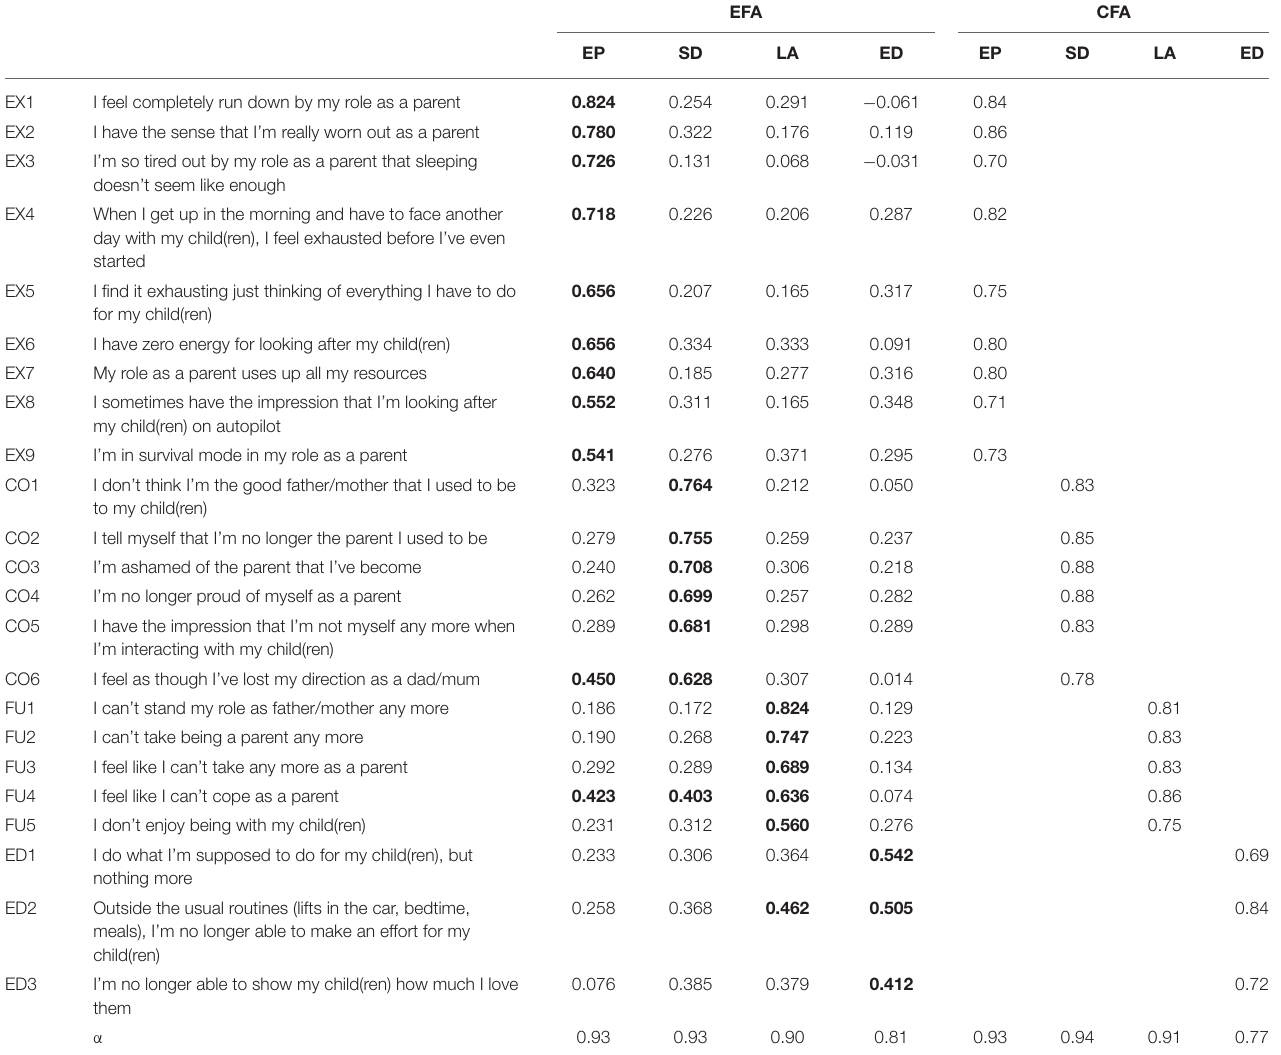
TABLE 1 | Loading parameter estimates in EFA from the four-factor solution and reliability estimates for the 23-item version of the PBA in subsample 1 ( N = 451) and standardized regression weights from CFA and reliability estimates for the final 23-item version of the PBA in subsample 2 ( N = 450). EFA CFA